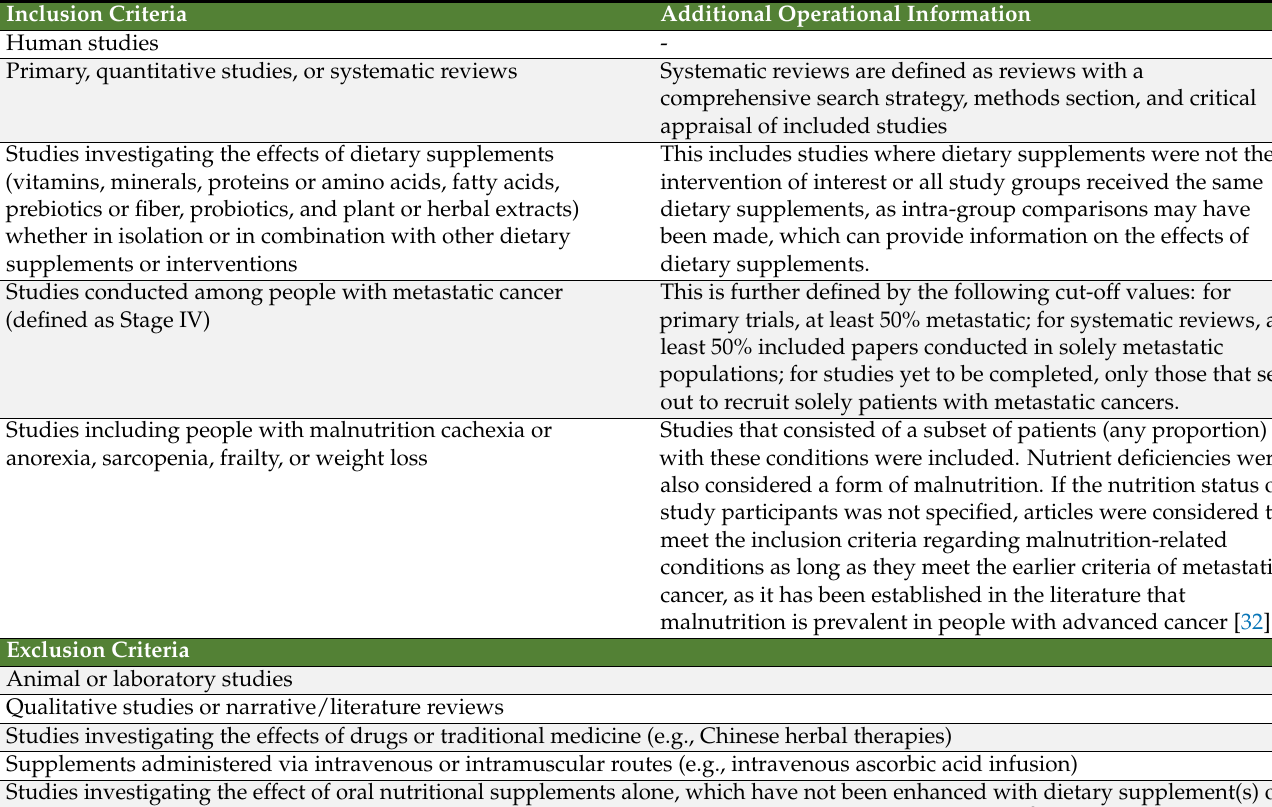
Table 1. List of inclusion and exclusion